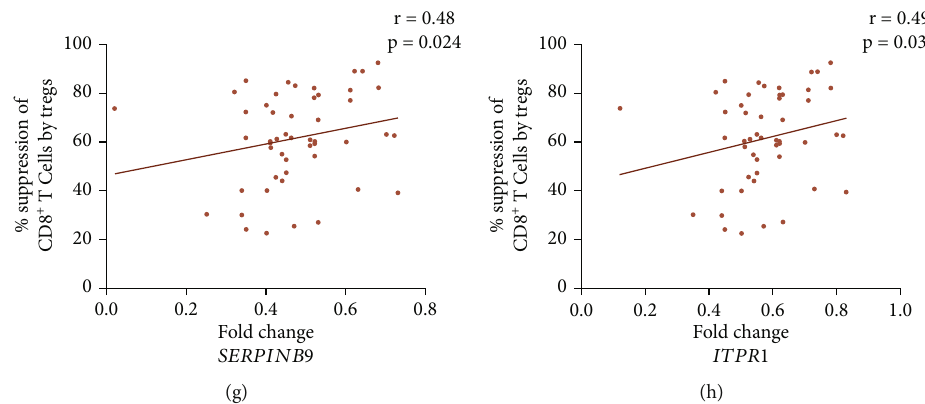
Figure 5: Correlation of in vitro Treg suppression assay with ITPR1 , GZMB , NRP1 , and SERPINB9 transcripts in Tregs of GV patients. The correlation of in vitro Treg suppression assay with ITPR1 , GZMB , NRP1 , and SERPINB9 was analyzed by Spearman ’ s correlation analysis. (a) GZMB transcripts were positively correlated with in vitro Treg mediated suppression of CD4 + T cells in GV patients ’ Tregs ( r = 0 : 61 ; p = 0 : 0012 ). (b) NRP1 transcripts were positively correlated with in vitro Treg-mediated suppression of CD4 + T cells in GV patients ’ Tregs ( r = 0 : 55 ; p = 0 : 021 ). (c) SERPINB9 transcripts were positively correlated with in vitro Treg-mediated suppression of CD4 + T cells in GV patients ’ Tregs ( r = 0 : 56 ; p = 0 : 002 ). (d) ITPR1 transcripts were positively correlated with in vitro Treg-mediated suppression of CD4 + T cells in GV patients ’ Tregs ( r = 0 : 54 ; p = 0 : 001 ). (e) GZMB transcripts positively correlated with in vitro Treg-mediated suppression of CD8 + T cells in GV patients ’ Tregs ( r = 0 : 58 ; p = 0 : 004 ). (f) NRP1 transcripts positively correlated with in vitro Treg- mediated suppression of CD8 + T cells in GV patients ’ Tregs ( r = 0 : 52 ; p = 0 : 0022 ). (g) SERPINB9 transcripts positively correlated with in vitro Treg-mediated suppression of CD8 + T cells in GV patients ’ Tregs ( r = 0 : 48 ; p = 0 : 024 ). (h) ITPR1 transcripts positively correlated with in vitro Treg-mediated suppression of CD8 + T cells in GV patients ’ Tregs ( r = 0 : 49 ; p = 0 : 032 NRP1 , PDCD1 , FASLG , and TNFRS18 in GV patients.